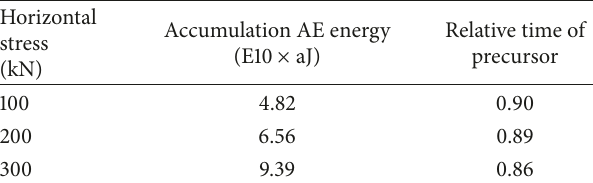
Table 3: Accumulation AE energy and precursor time for different horizontal